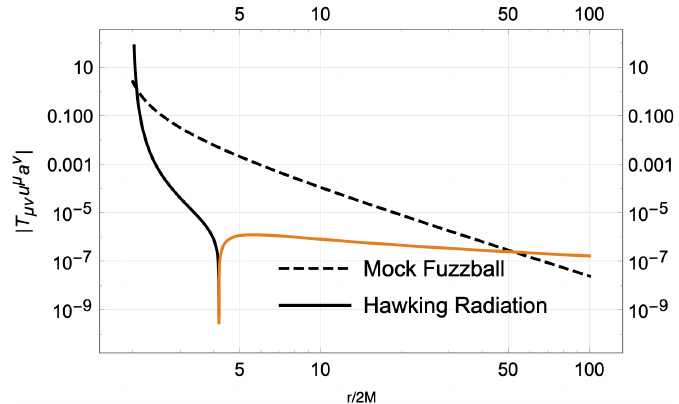
Figure 6. The energy density of mock fuzzball, compared with that of Hawking radiation as seen by a radially infalling observer along a geodesic. Here the orange curve is positive and the black curve is negative. The energy density of mock fuzzball is larger than the Hawking radiation near horizon and drops faster than the Hawking radiation away from the horizon.